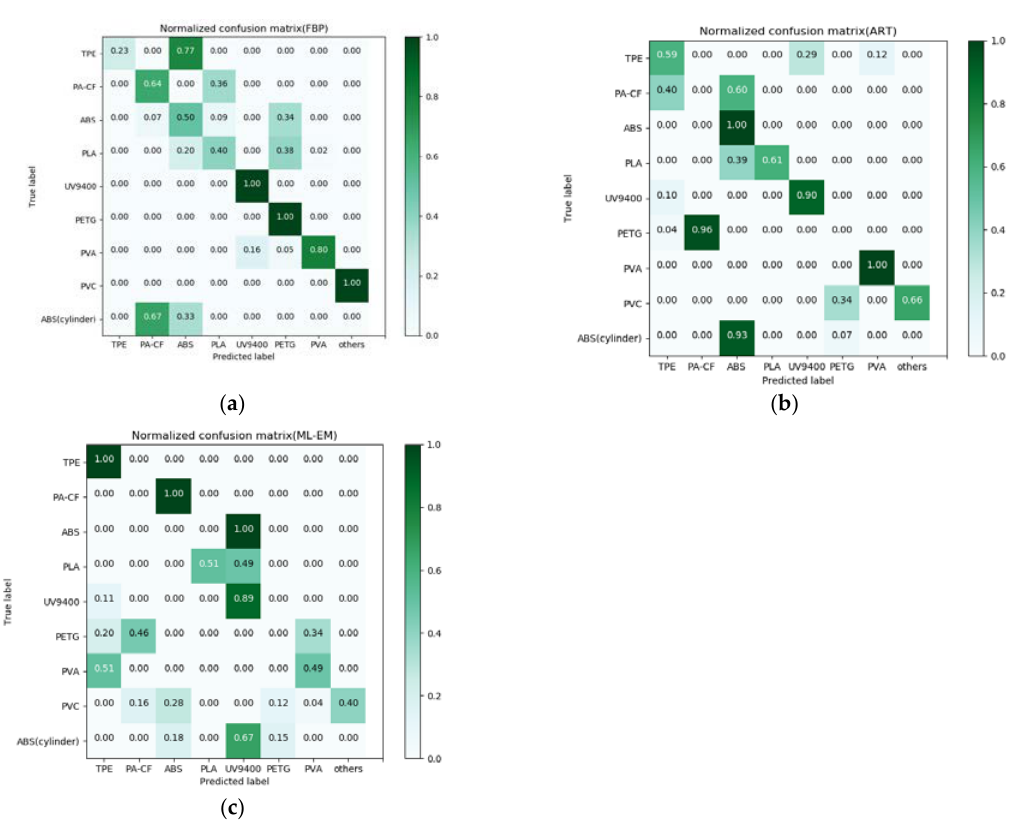
Figure 13. ( a ) Normalized confusion matrix of ANN under FBP and ART ( b ) as well as ML-EM ( c ).